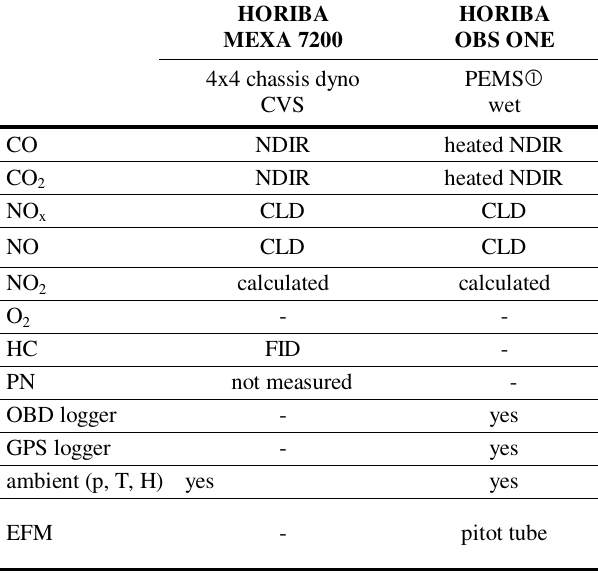
Table 1. Overview of used measuring systems